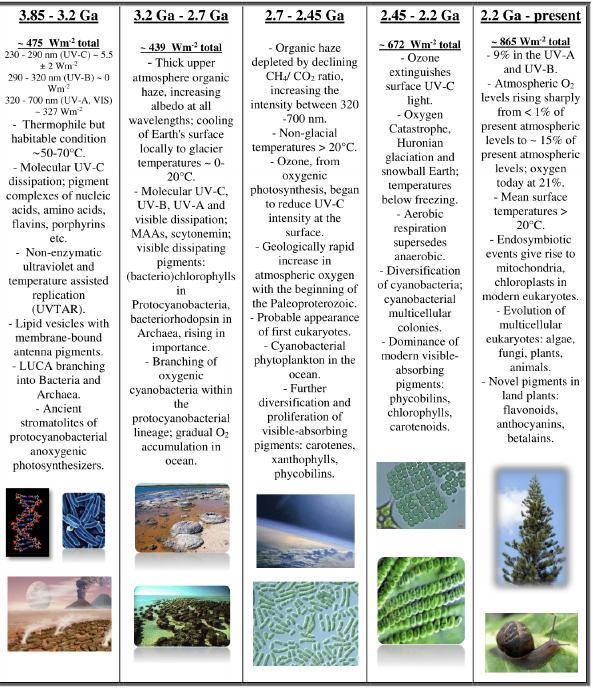
Figure 4. Timeline demonstrating the correlation between the pre- vailing surface solar spectrum and the appearance and distribution of organic pigments. Major milestones in the evolution of life are also noted in the